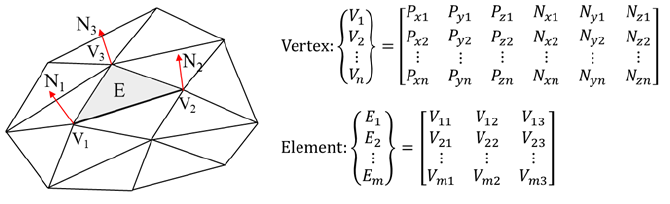
Figure 3. Data types for a triangular element.